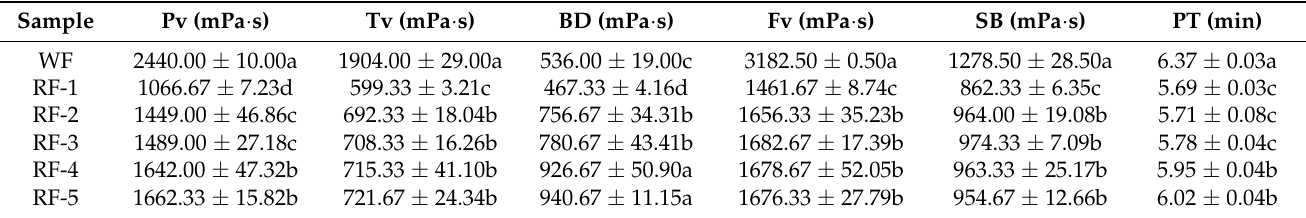
Table 2. Effect of highland barley flour with different particle sizes on the pasting property of